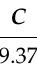
Table 2. Mechanical parameters of the support.